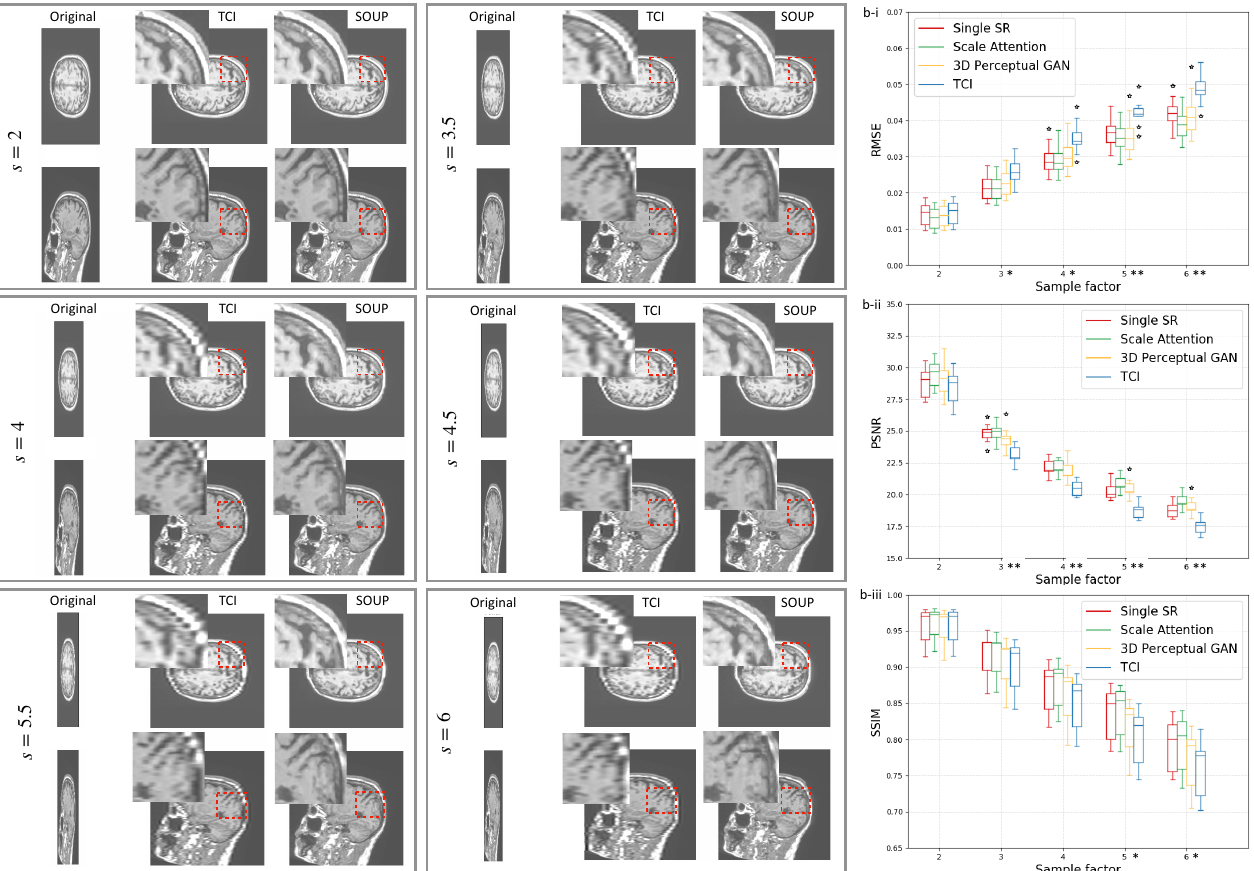
Figure 3. ( a ) Comparison between scale-attention model and cubic interpolation at different scales. ( b ) T1-weighted brain MRI test dataset with quantitative comparisons of measures: ( b-i ) RMSE, ( b-ii ) PSNR, and ( b-iii ) SSIM in terms of the sampling factor s. As a reference, DeepResolve proposed by [32] as a single-scale residual-based 3D CNNs with MSE is similar to the single SR reported here (in red). Statistical significance is indicated on the x-axes with * for p < 0.05 and ** for p < 0.001. TCI: tricubic interpolation; GT: ground